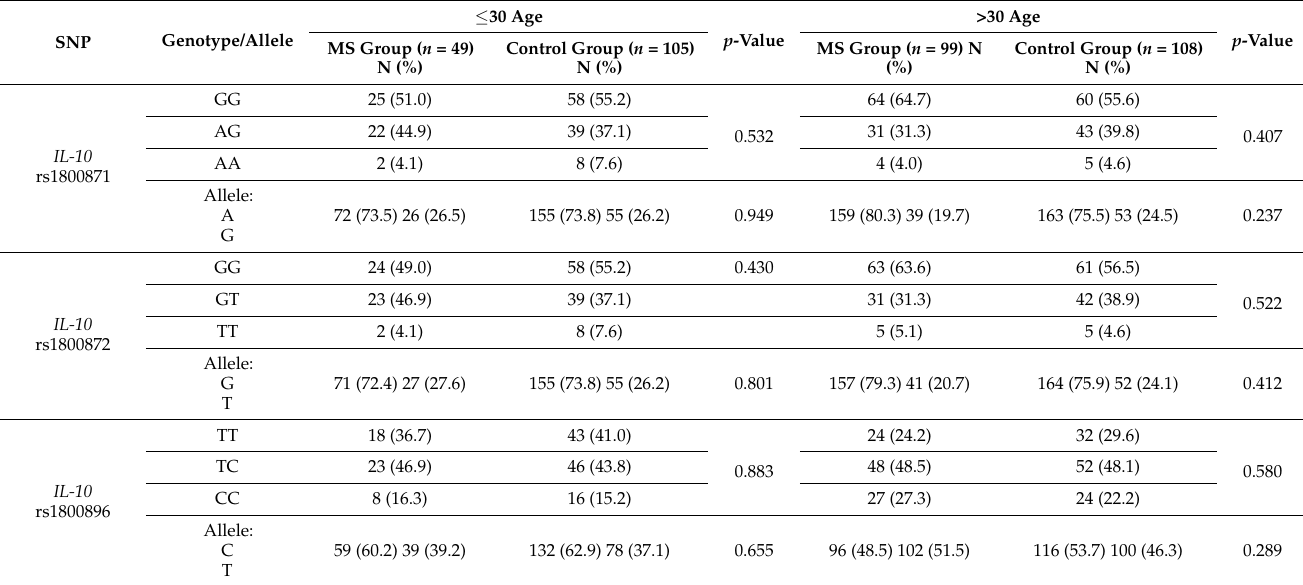
Table 3. Comparison of IL-10 rs1800871, rs1800872, and rs1800896 polymorphisms in multiple sclerosis patients by age.